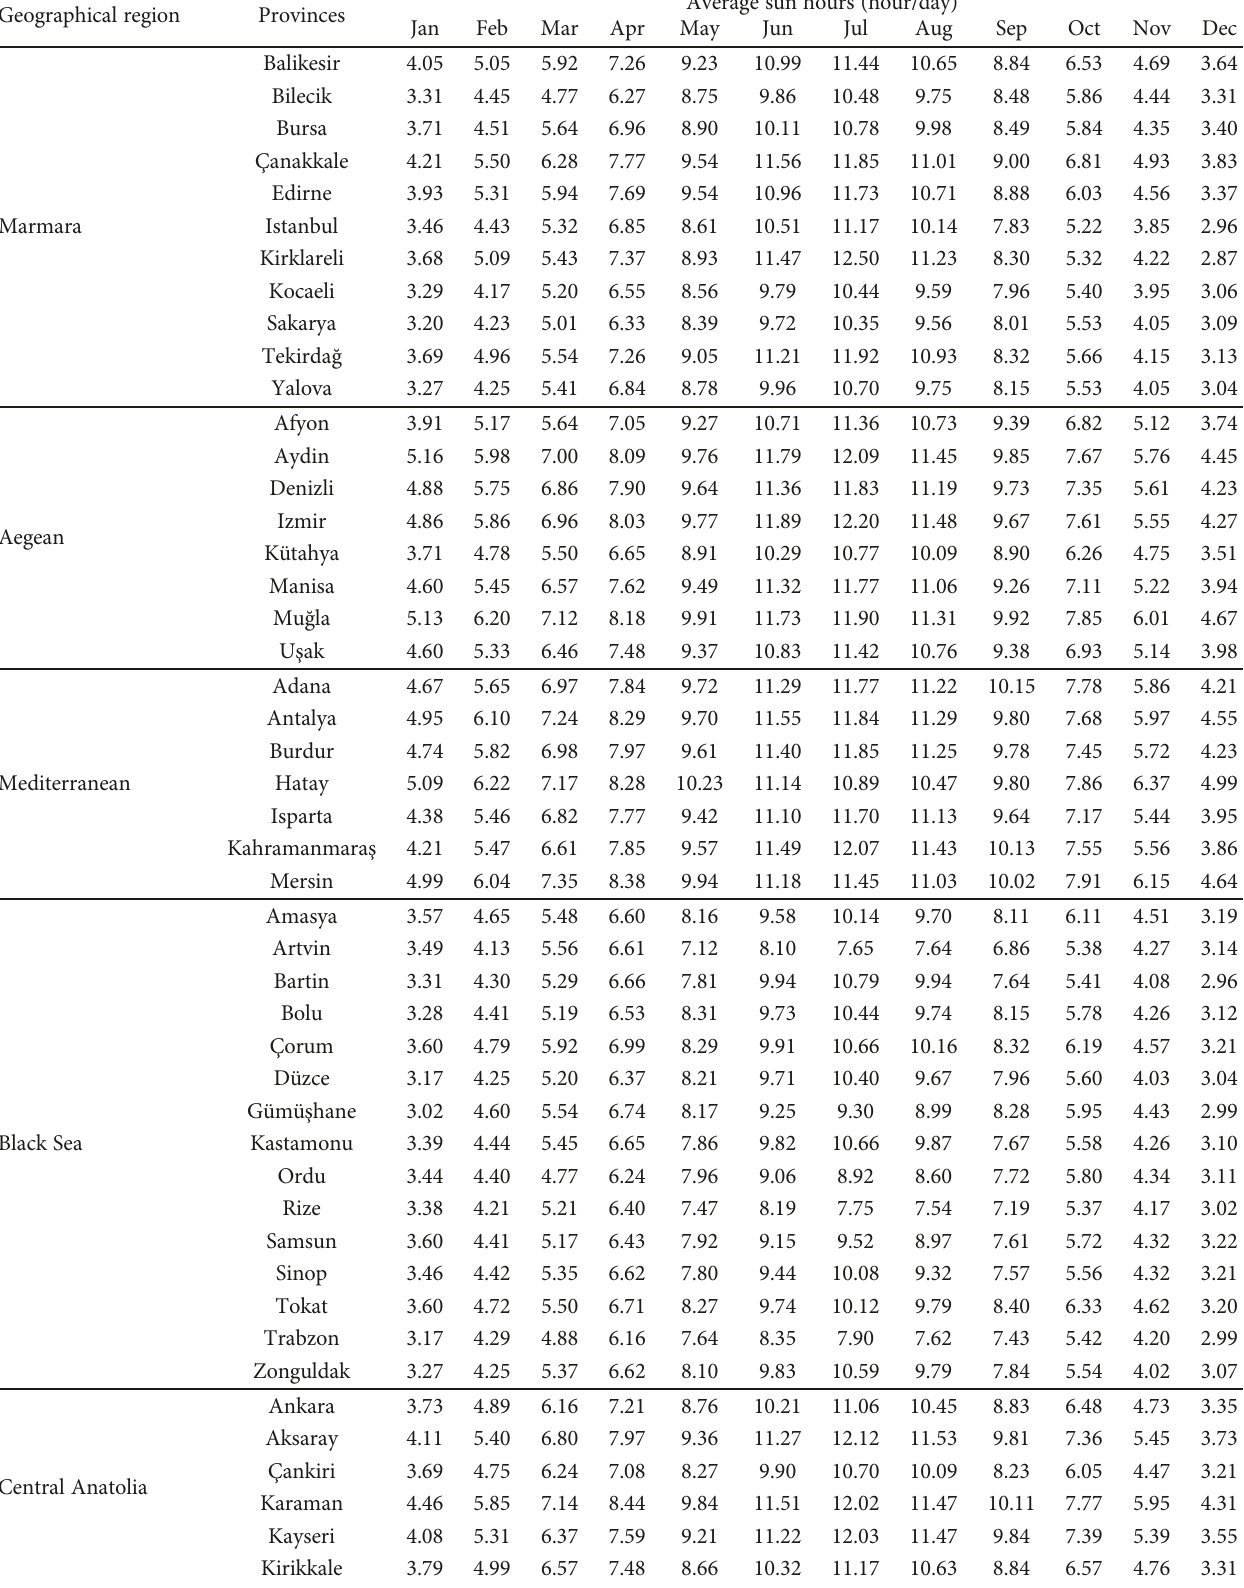
Table 2: Average sun hours of Turkey ’ s provinces